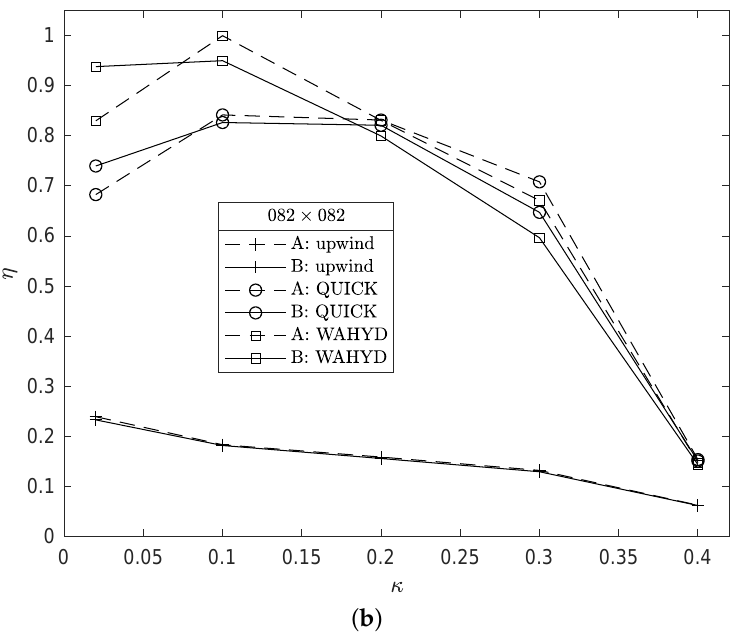
Figure 16. Computational efficiency as function of κ for the flow between concentric cylinders case and grids: ( a ) 62 × 62, ( b ) 82 × 82.